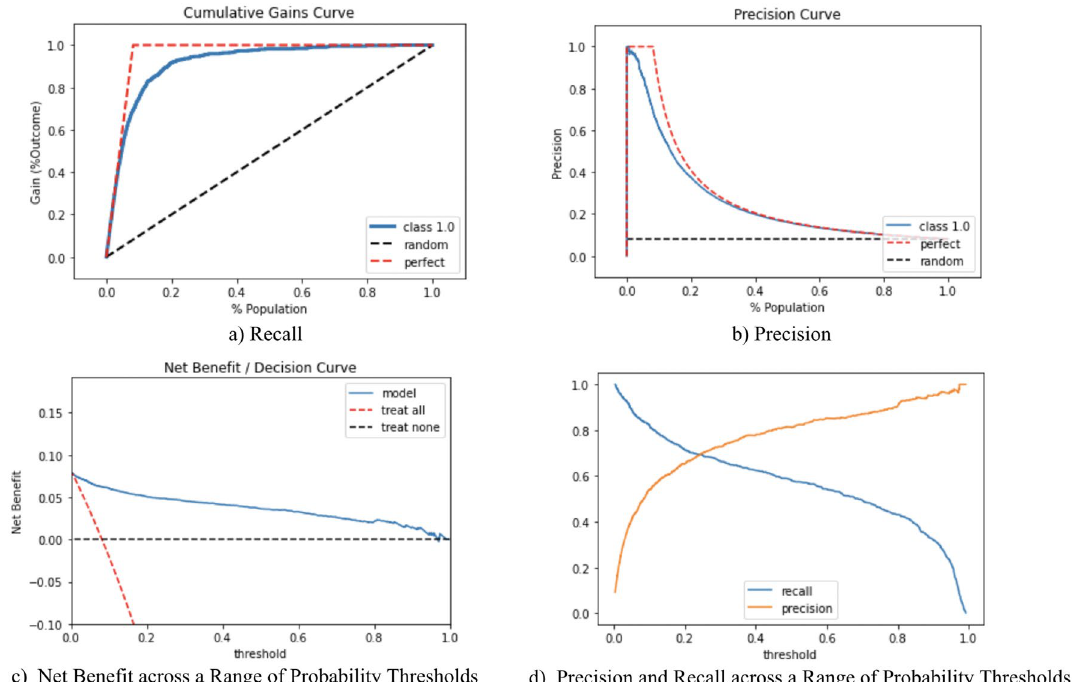
Figure 2. Cost–benefit